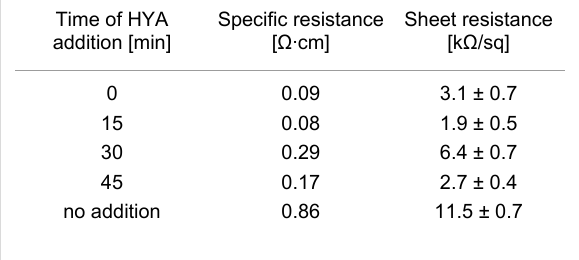
Table 2: Electrical properties of ZnO films: comparison of the specific resistance and sheet resistance of ZnO films after the second CBD step. The films were grown with different addition times of HYA during the first CBD step and without HYA. The films were exposed to UV ir- radiation during the